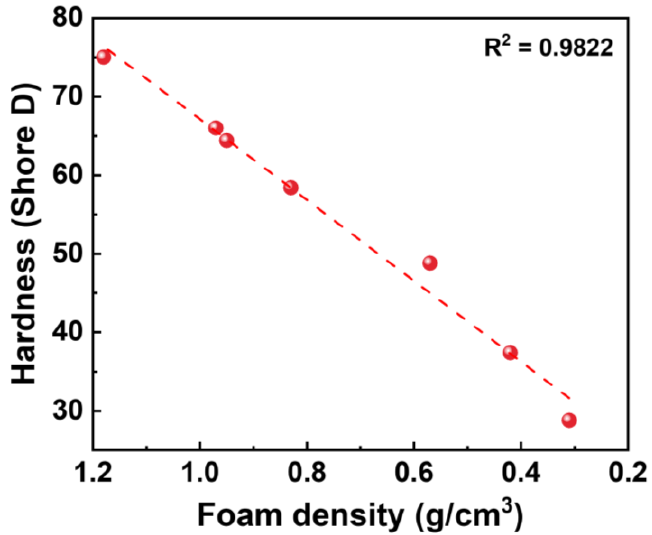
Figure 14. The relationship between foam density and hardness. The red dotted line represents the fitting result.